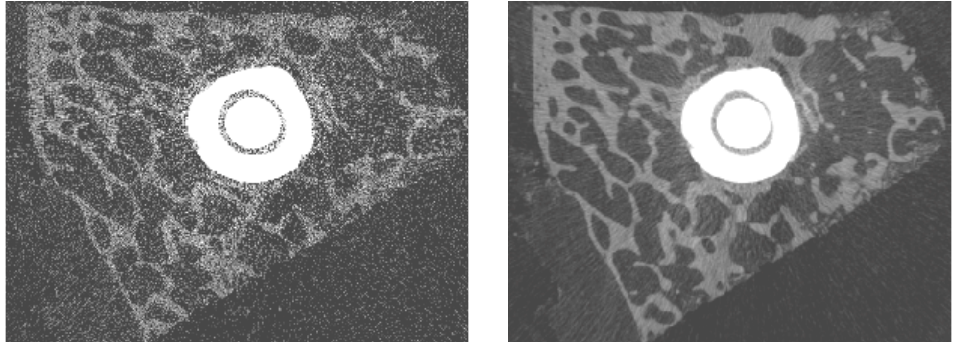
Figure 3. Reconstructed µCT images of Ti implant in bone (middle portion) before Gaussian filter application (a), and after application (b), pixel radii = 4 pixel The results indicate that a radius of 4 pixels was optimal in terms of the signal to noise ratio. The average gray scale level intensity of the healed cancellous bone before and after Gaussian filter application (4 pixels) was 55.15 (SD = 9.24) and 55.31 (SD = 3.30) (Figure 4), respectively. An example of the improved quality of the reconstructed images after Gaussian filter application (Figure 3) showed a significant reduction in the background noise associated with the high-density titanium